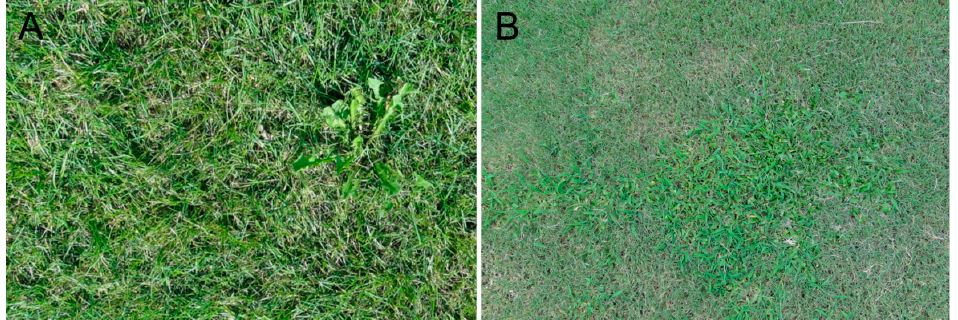
Figure 2. Dandelion ( Taraxacum officinale F.H. Wigg.) scatteringly grows in perennial ryegrass ( Lo- lium perenne L.) turf ( A ). Smooth crabgrass ( Digitaria ischaemum (Schreb.) Muhl) grows in a relatively large patch in bermudagrass turf ( B ).